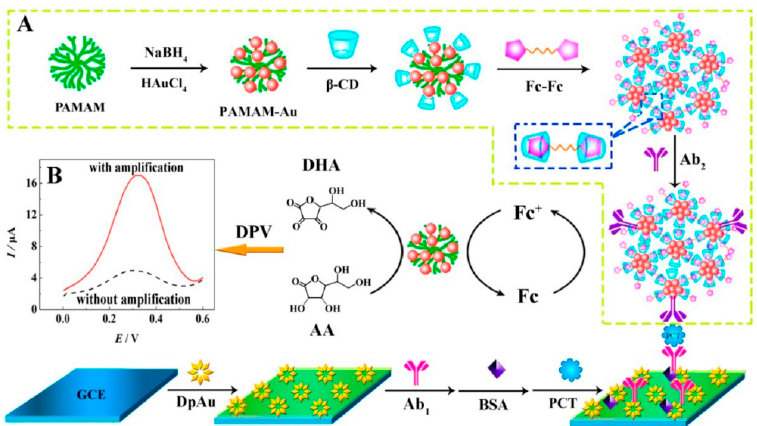
Figure 9. Schematic diagram of fabrication of electrochemical immunosensor for detection of procalcitonin (PCT). ( A ) Preparation procedure of Fc-Fc / β -CD / PAMAM-Au-labeled Ab2 bioconjugates. ( B ) Comparative DPV signals with and without amplification. Reproduced with permission from [74].